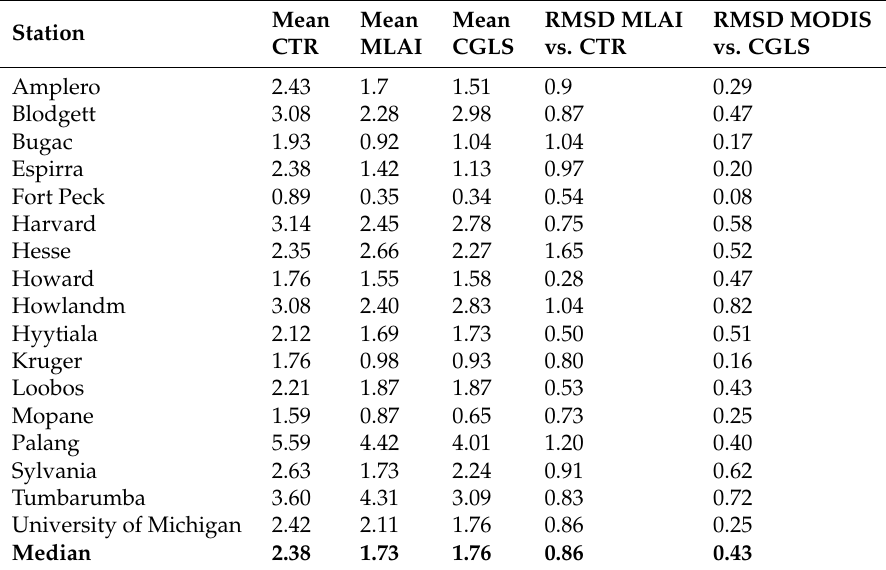
Table 5. Comparison between CTR and MODIS LAI (MLAI) for each tower. The root mean squared difference is computed for the mean annual cycle. CGLS, Copernicus Global Land